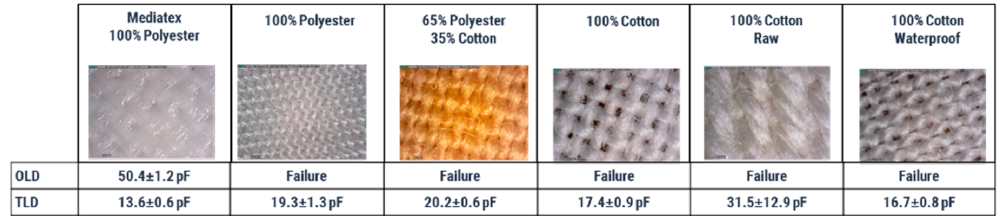
Figure 10. Capacitances and failures for each type of fabric and design.